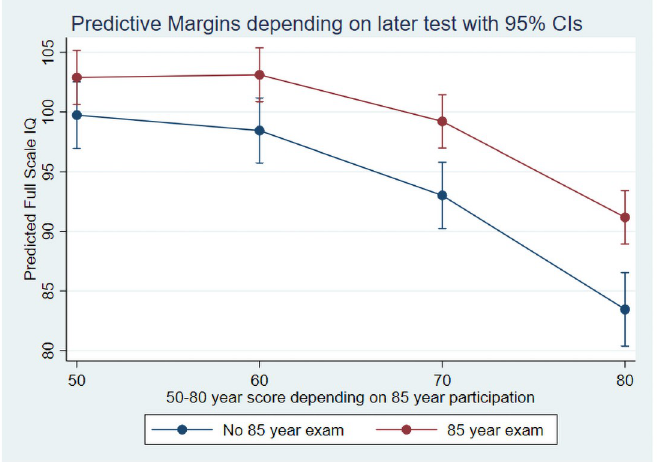
Fig 4. Full-scale IQ trajectories according to participation or non-participation in the 85-year follow-up.